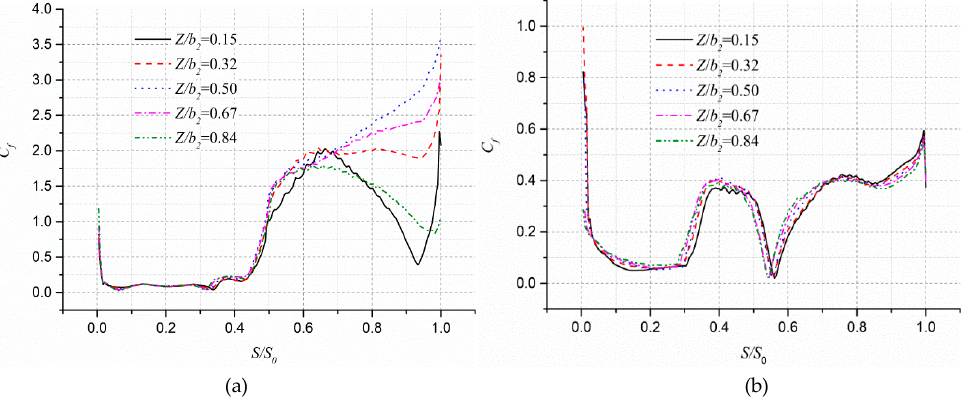
Figure 9. Comparison of the skin friction coefficient on the blade surface at different axial cross sections: ( a ) pressure surface and ( b ) suction surface. ( a ) pressure surface and ( b ) suction